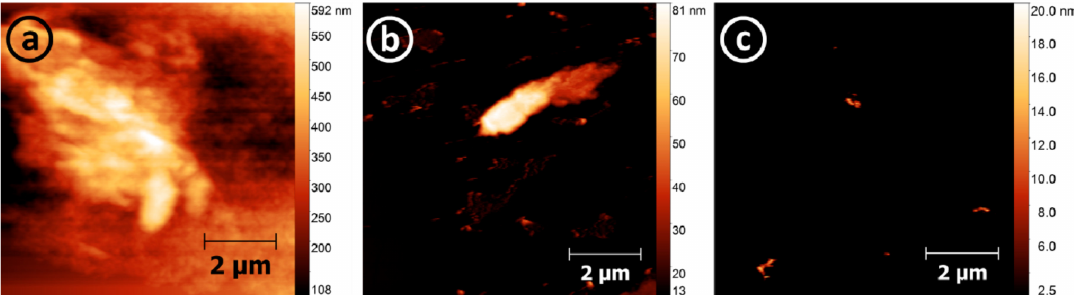
Figure 8. Atomic force microscopy (AFM) typical morphologies of aggregated A β 25-35 in the